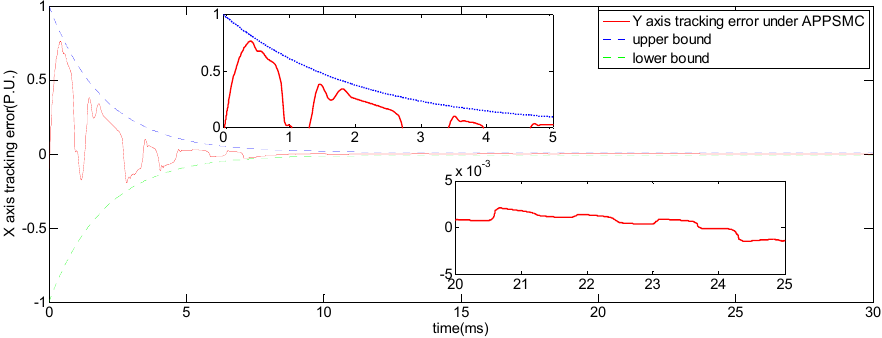
Figure 12. X axis tracking error under low frequency noise.